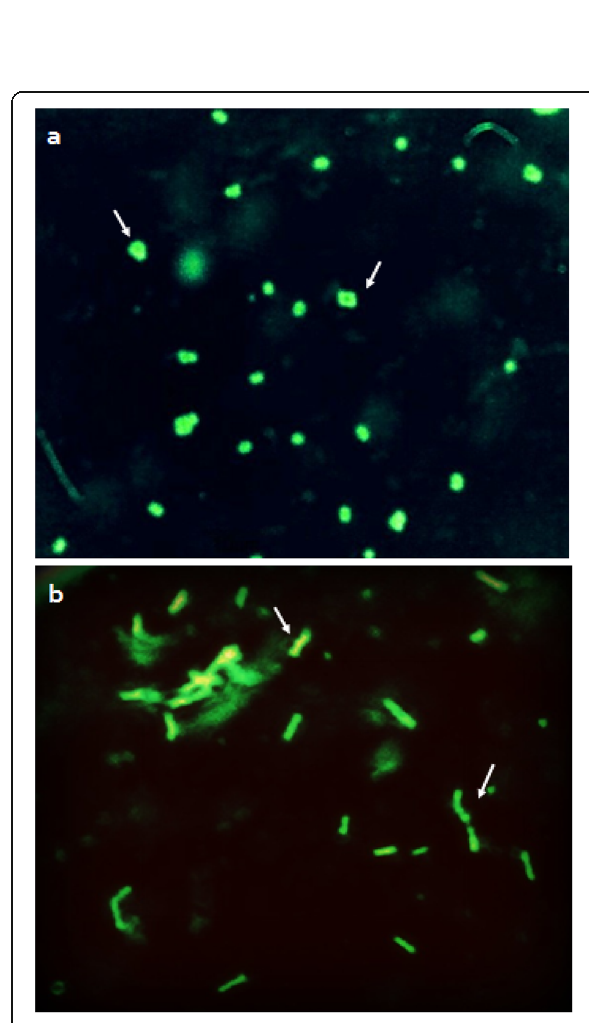
Fig. 6 Cells of host LAB strains under fluorescence microscope (× 3000). a P. acidilactici MTCC 5101. b L. brevis MTCC 1750. White arrows depict tetrads clusters of P . acidilactici and rods of L .